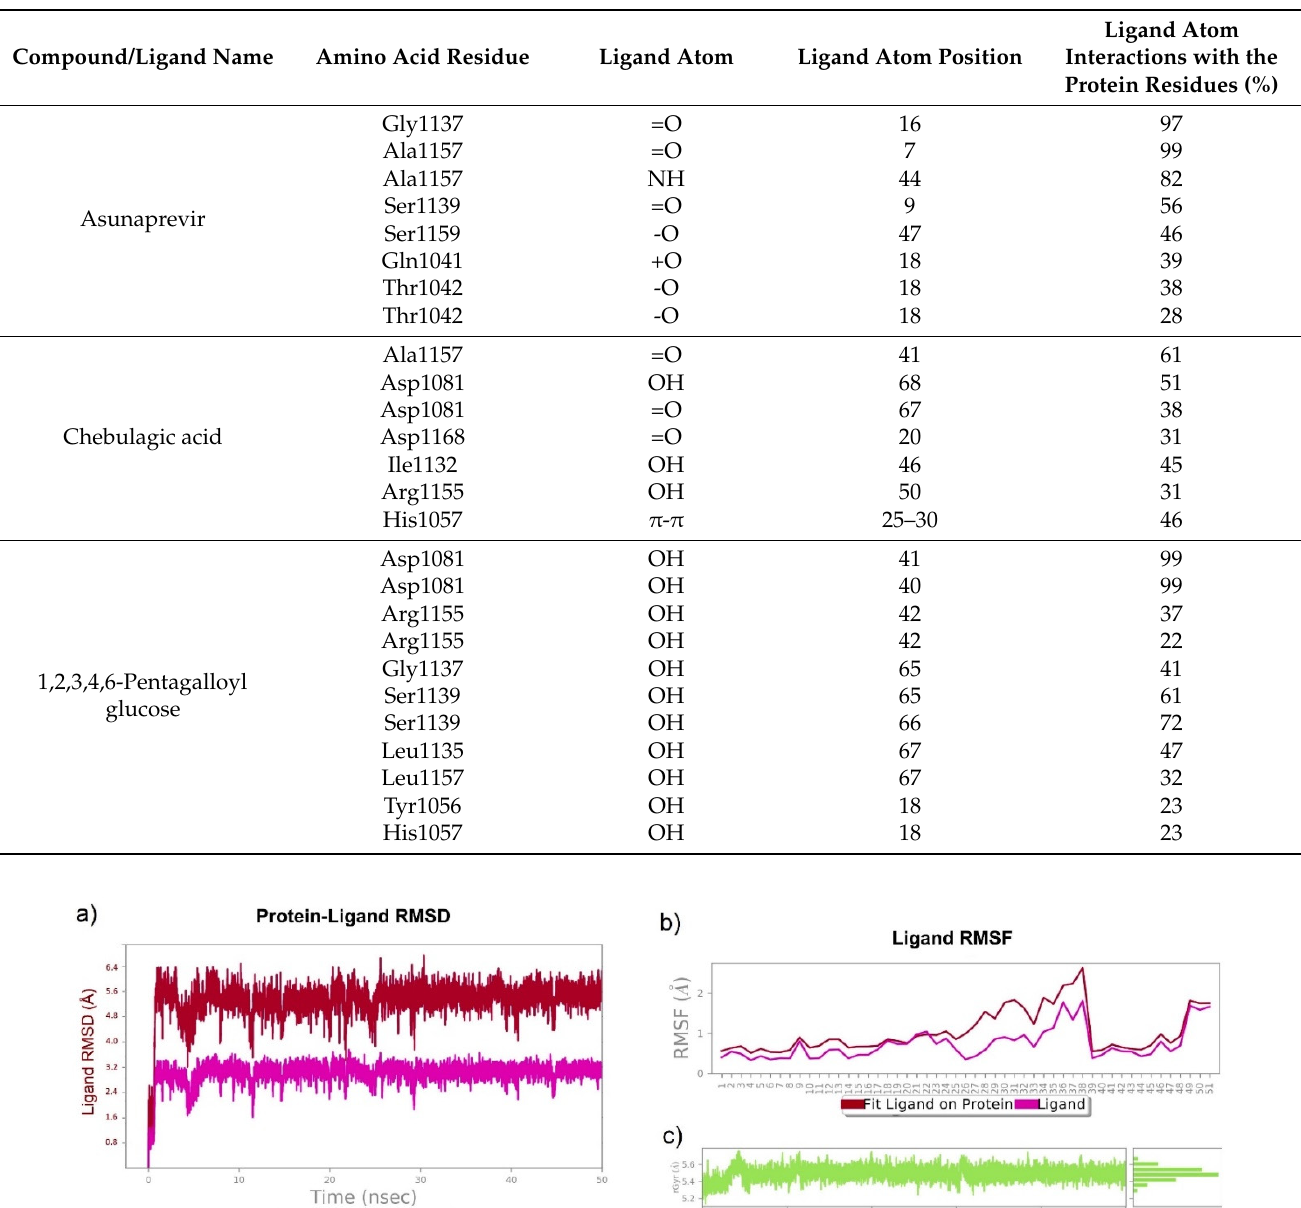
Table 4. Interactions of compounds with HCV NS3/4A after 50ns MD simulation.